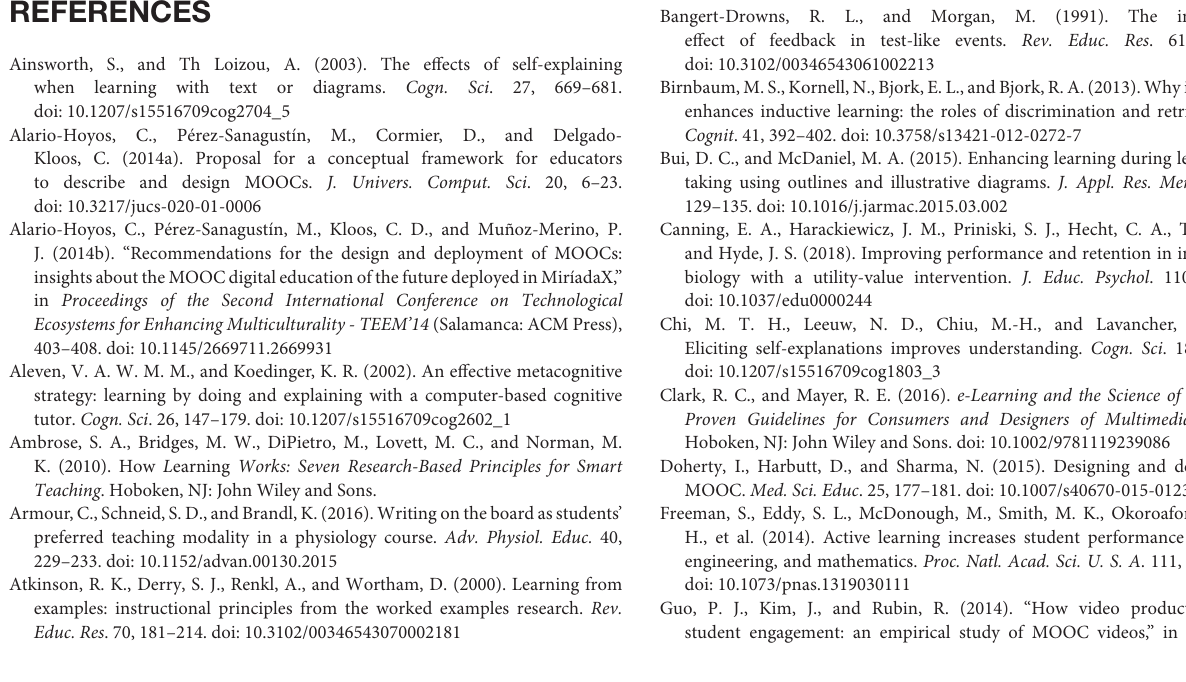
Supplementary Figure 1 | An example of an image handout from the protein structure learning sequence highlighting essential images complete with focused, open-ended concept